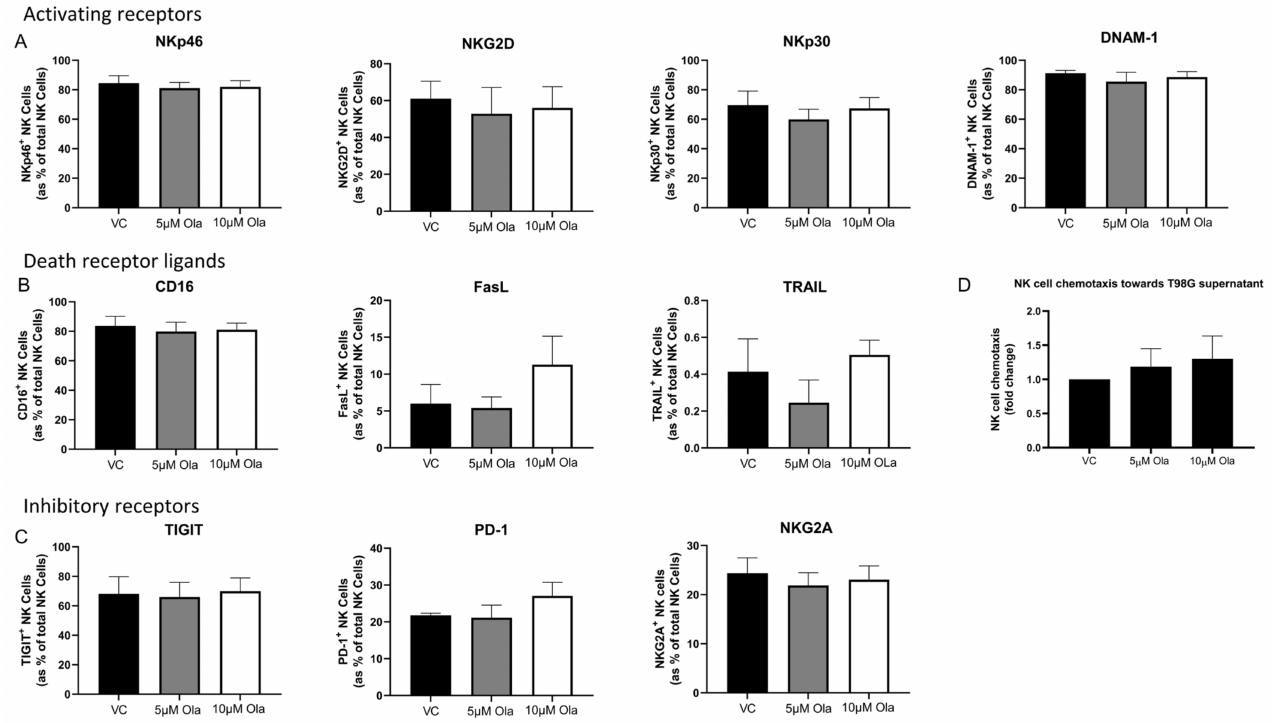
Figure 5. NK cell phenotype is not significantly altered by Olaparib treatment. Bar charts showing frequencies of ( A ) NKp46 + , NKG2D + , NKp30 + (activating receptors), ( B ) CD16 + , FasL + , TRAIL + (death receptor ligands) and ( C ) TIGIT + , PD-1 + , NKG2A + inhibitory receptor NK cells as % of total NK cells following treatment with vehicle control (black) or 5 µ M (grey) or 10 µ M (white) of Olaparib for 24 h. ( D ) Bar chart showing the migration of NK cell towards the soluble chemotactic cues of T98G cells following 24 h treatment of NK cells with 5 µ M or 10 µ M of Olaparib, relative to vehicle control (VC). One-way ANOVA with post hoc Dunn’s